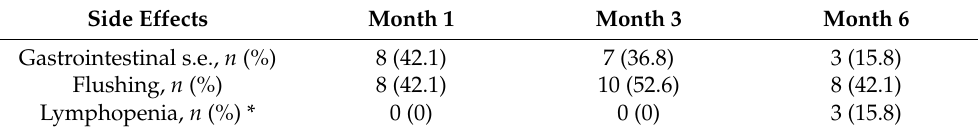
Table 3. Prevalence of side effects during the 6-month follow-up from treatment start with DMF.